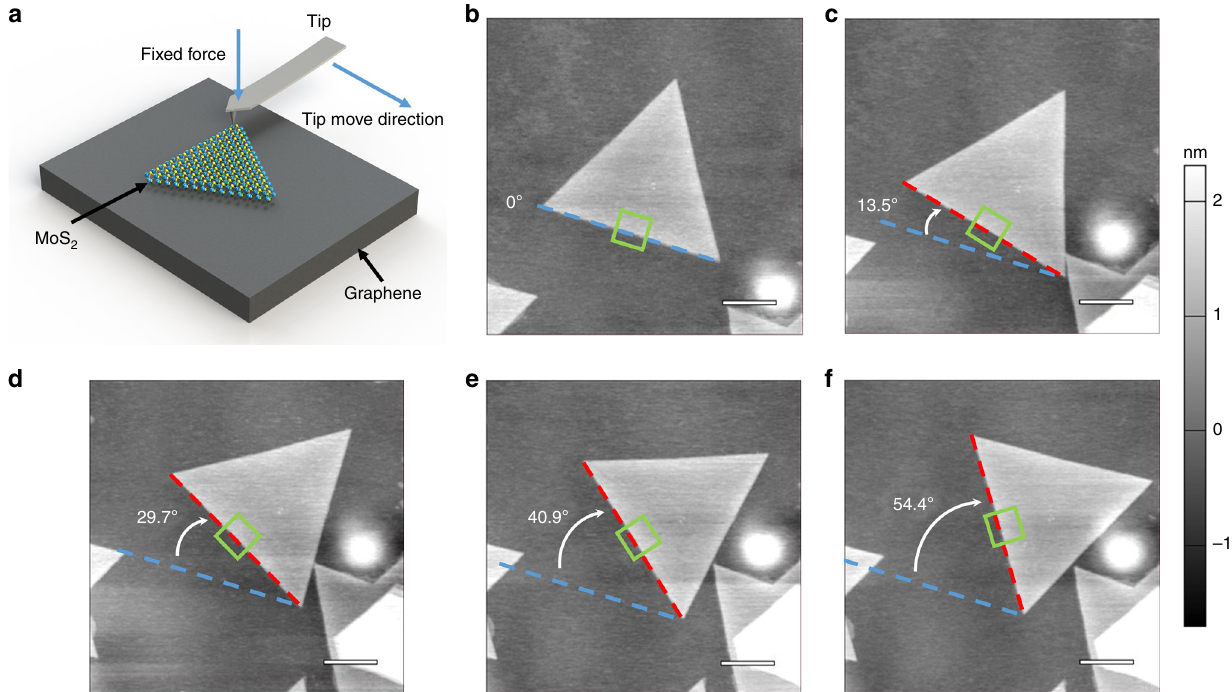
Fig. 2 Rotation of as-grown MoS 2 domains on graphene substrates. a Schematic of AFM-tip manipulation setup. b – f AFM images of a typical MoS 2 domain rotated on graphene to achieve a series of twist angles, scale bar, 1 μ m. Blue dash lines indicate the original direction of the MoS 2 domain, while white arrows indicate the rotation directions. Green rectangles represent the scan area during C-AFM